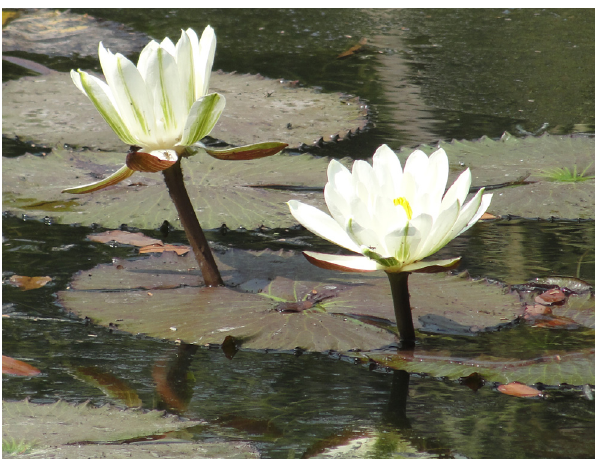
Fig. 7. Flowering twig of Nymphaea pubescens Willdenow